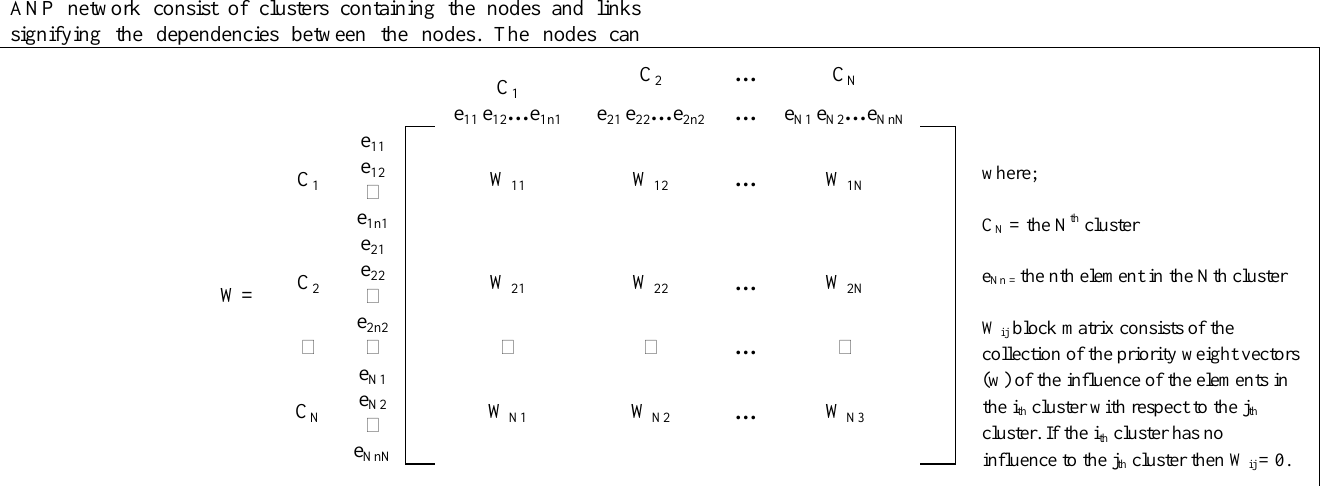
Figure 4: Supermatrix of